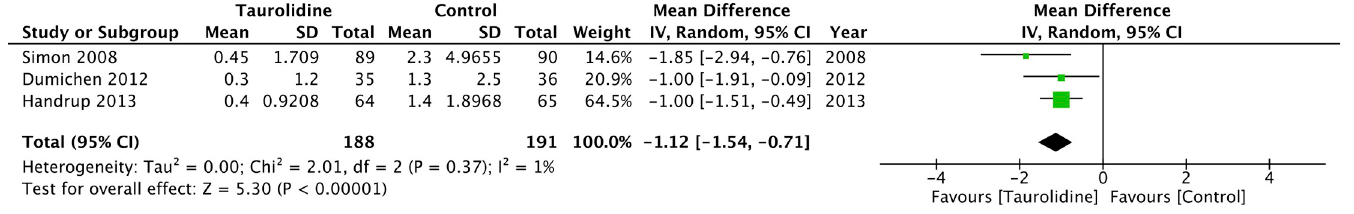
Fig 4. Forest plot of taurolidine versus control for an incidence rate of CRBSI.